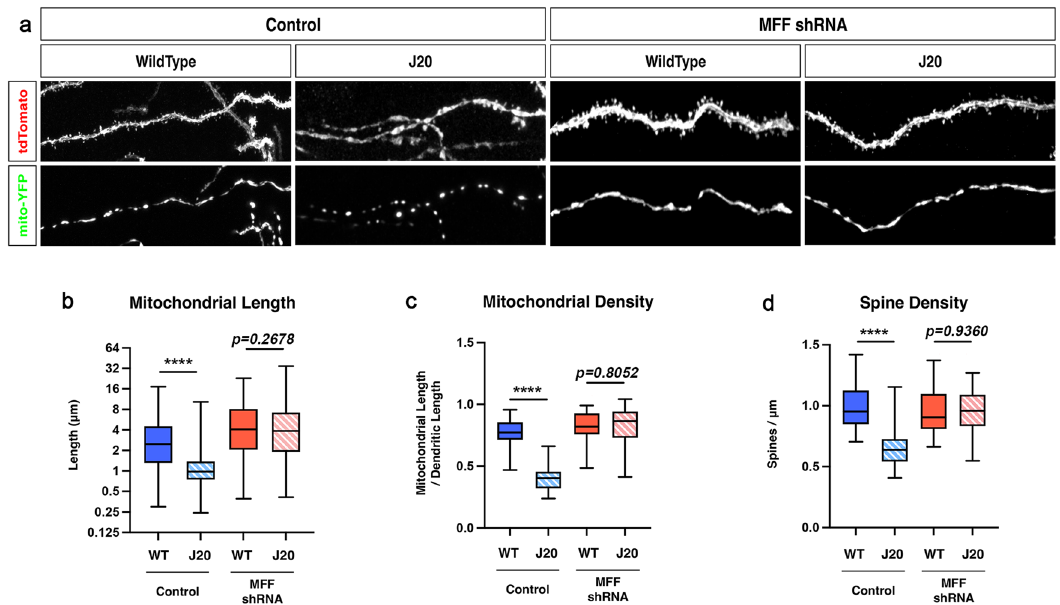
Fig. 6 | MFF is required for A β 42o-induced dendritic mitochondrial fragmen- tation and spine loss in apical tufts of CA1 PNs in vivo. a High-magni fi cation imagesofdendriticsegmentsinstratumlacunosummoleculare(SLM)ofCA1PNsof 3-months-old WT or J20 mice. CA1 PNs were co-electroporated in utero at E15.5 with plasmids expressing a cell fi ller (tdTomato), a mitochondrial matrix marker (mito-YFP) and either control (scrambled) shRNA or shRNA targeting mouse MFF. b – d Quanti fi cation of dendritic mitochondrial length ( b ), dendritic mito- chondrial density ( c ), and dendritic spine density ( d ). Data are represented by box plots displaying minimum to maximum values, with the box denoting